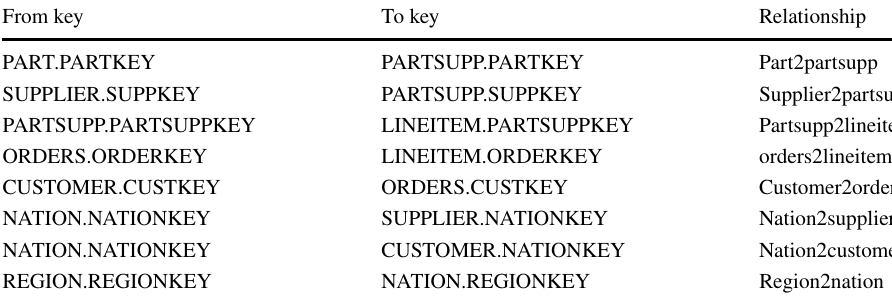
From key To key